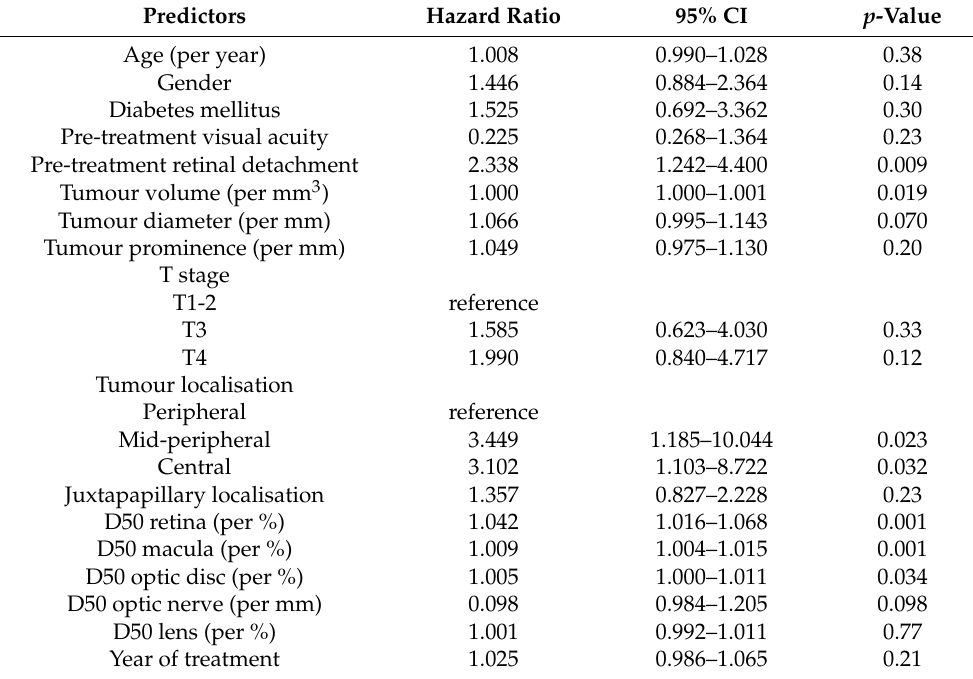
Table 4. Risk factors for decline in visual acuity < 0.1 after proton